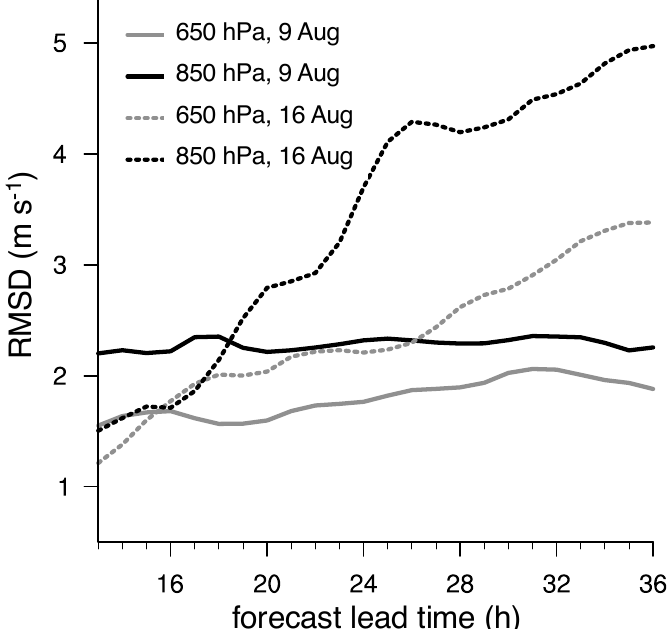
Figure 4. Root Mean Squared Difference (RMSD) evolution between the ICON-HiRes and IFS forecasts initialized on 9 and 16 August and for the total wind speed at 650 and at 850 hPa. Only data over land and between 10 ◦ N and 15 ◦ N are